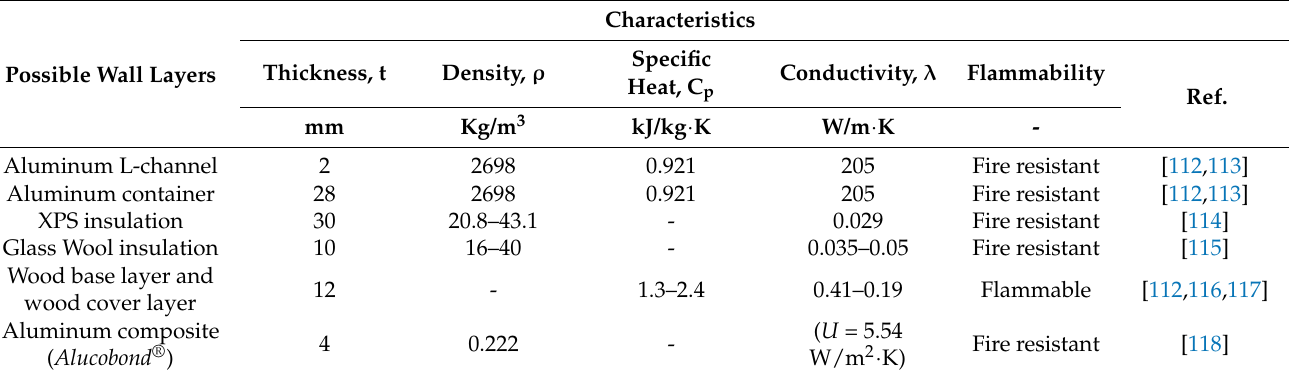
Figure 16. Joining the frames and L-channels: ( a ) outside view of the corner, ( b ) inside view of the corner, ( c ) suitable screws, and ( d ) L-connectors used. Table 4. Characteristics of possible wall layers used in the initial assembly of the